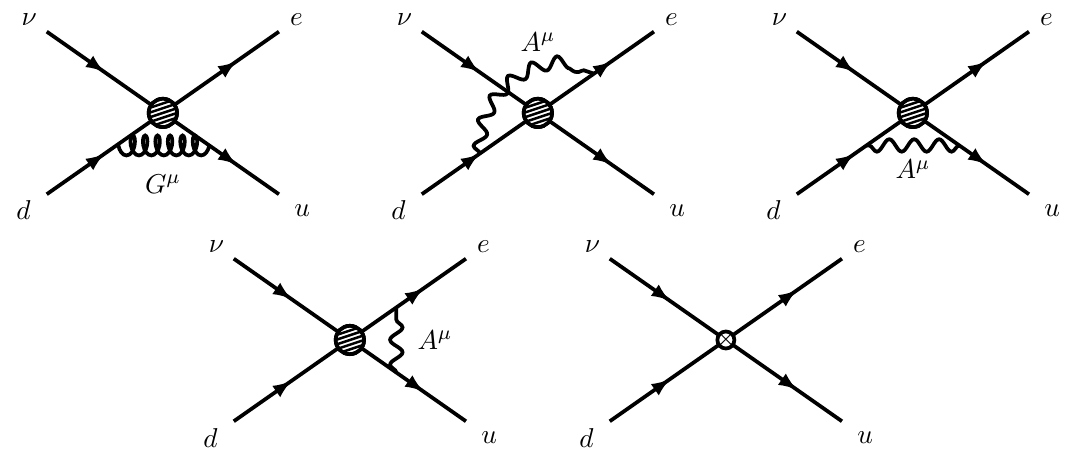
Figure 7. One-loop vertex corrections and counterterm for CC operators.